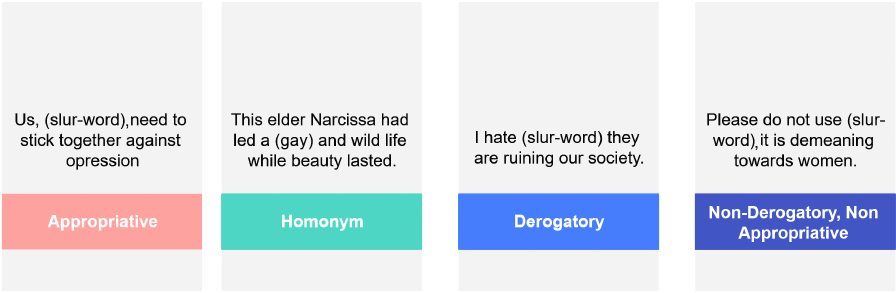
Figure 2. Usage types for Hate Speech key